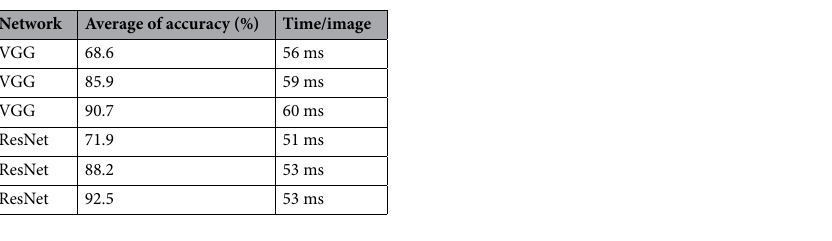
Table 2. Result of the ablation experiment.